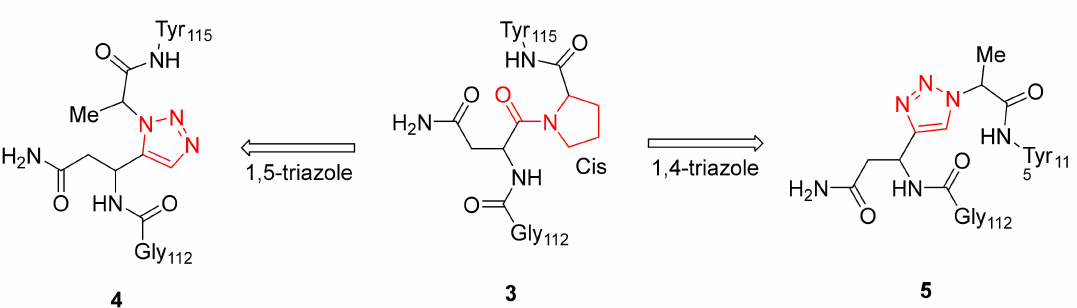
Figure 5. Substitution of the cis -prolyl peptide bond with 1,4- and 1,5-disubstituted triazole